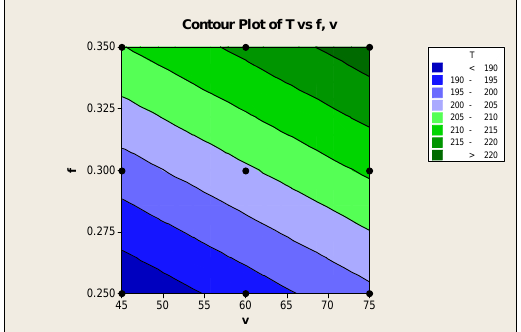
Contour Plot of T vs f, v